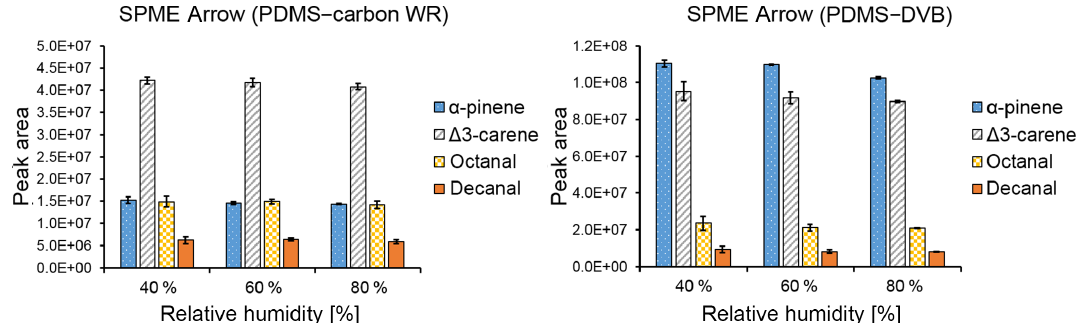
Figure 5. Effect of relative humidity (%) on the extraction efficiencies obtained with SPME Arrow using with PDMS–carbon WR and PDMS–DVB